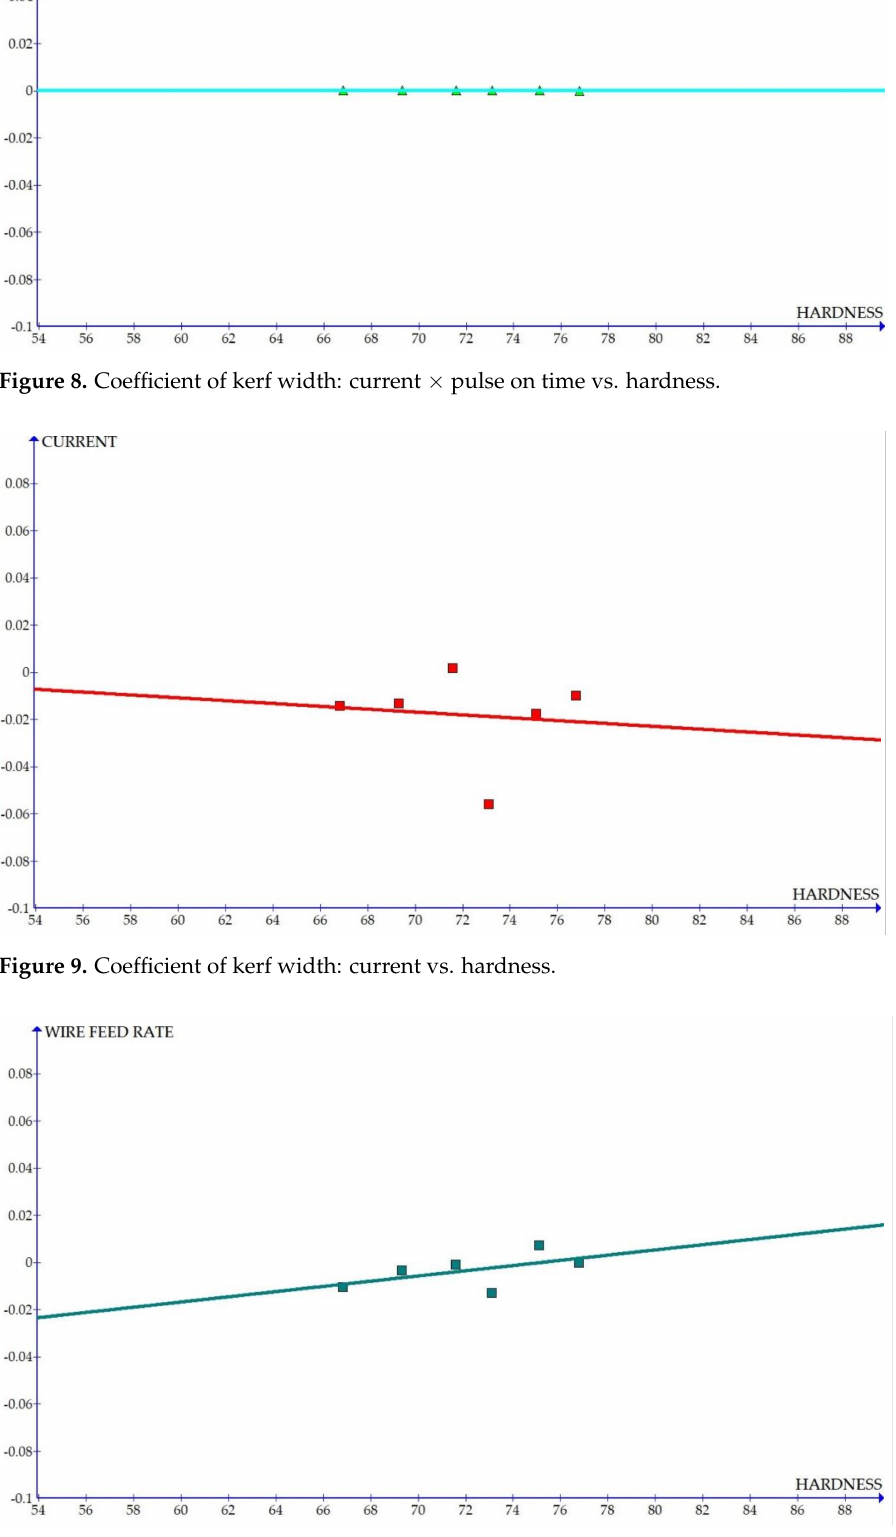
Figure 10. Coefficient of kerf width: wire feed rate vs.